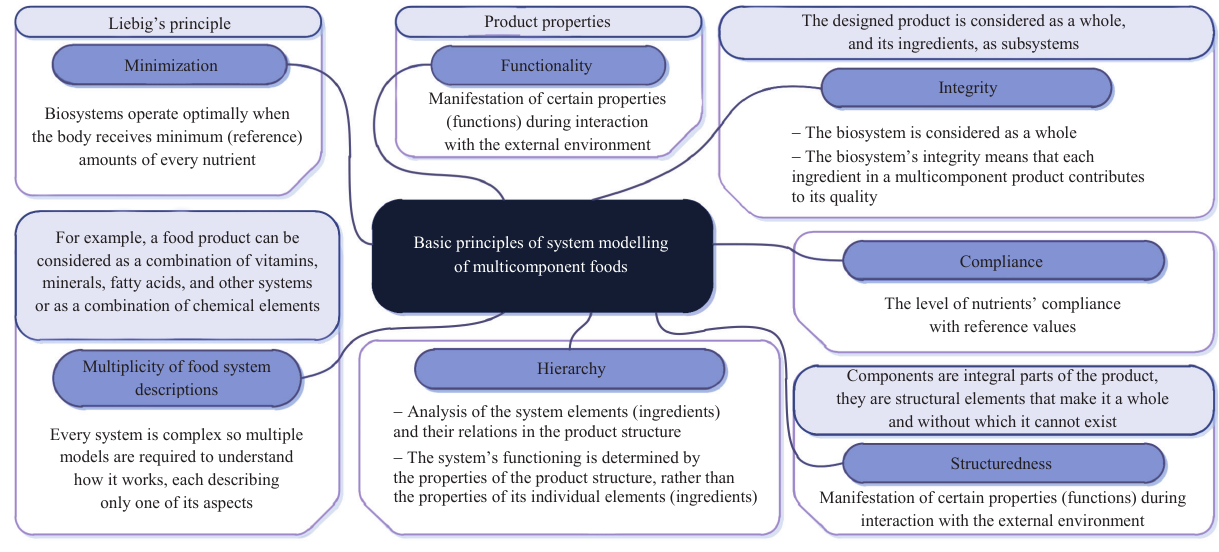
Figure 3 Basic principles of system modelling of multicomponent products [27]